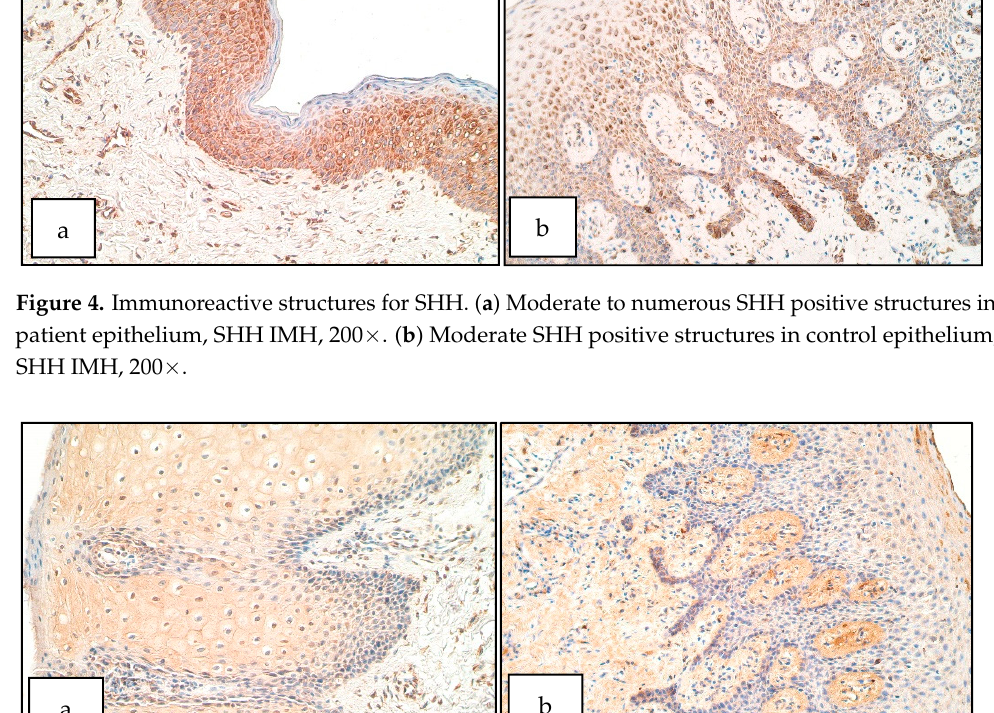
Figure 4. Immunoreactive structures for SHH. ( a ) Moderate to numerous SHH positive structures in patient epithelium, SHH IMH, 200×. ( b ) Moderate SHH positive structures in control epithe- lium, SHH IMH, 200×.